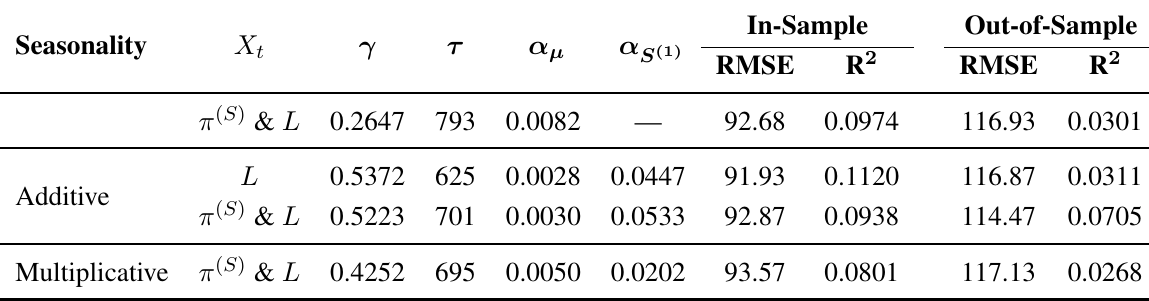
Table 4. The estimated model parameters along with performance measures for the best performing up-regulation penalty models. In-sample measures are for the training set, and out-of-sample ones relate to the test set.